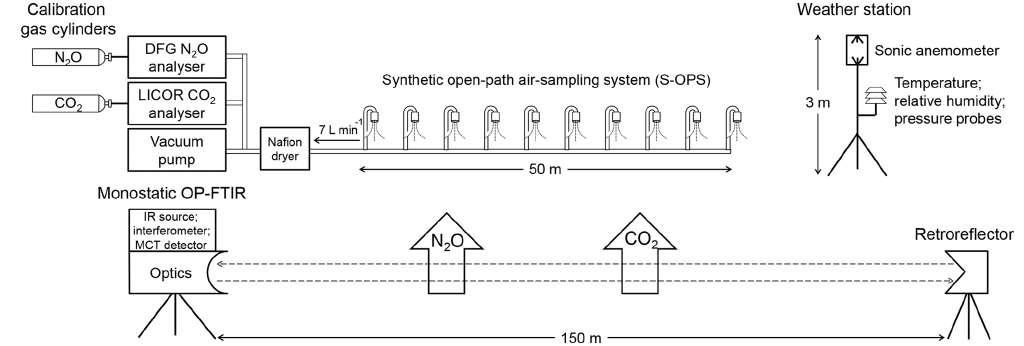
Figure 1. Schematic of the instrumentation used to assess the accuracy of N 2 O and CO 2 concentration determined by OP-FTIR in this study. DFG N 2 O and LI-840 CO 2 analysers combined with the synthetic open-path air-sampling system (S-OPS) were used to measure the actual path-averaged N 2 O / CO 2 concentrations and benchmark the N 2 O and CO 2 concentrations calculated from OP-FTIR spectral analyses. The humidity, air temperature, and wind information were measured from the weather